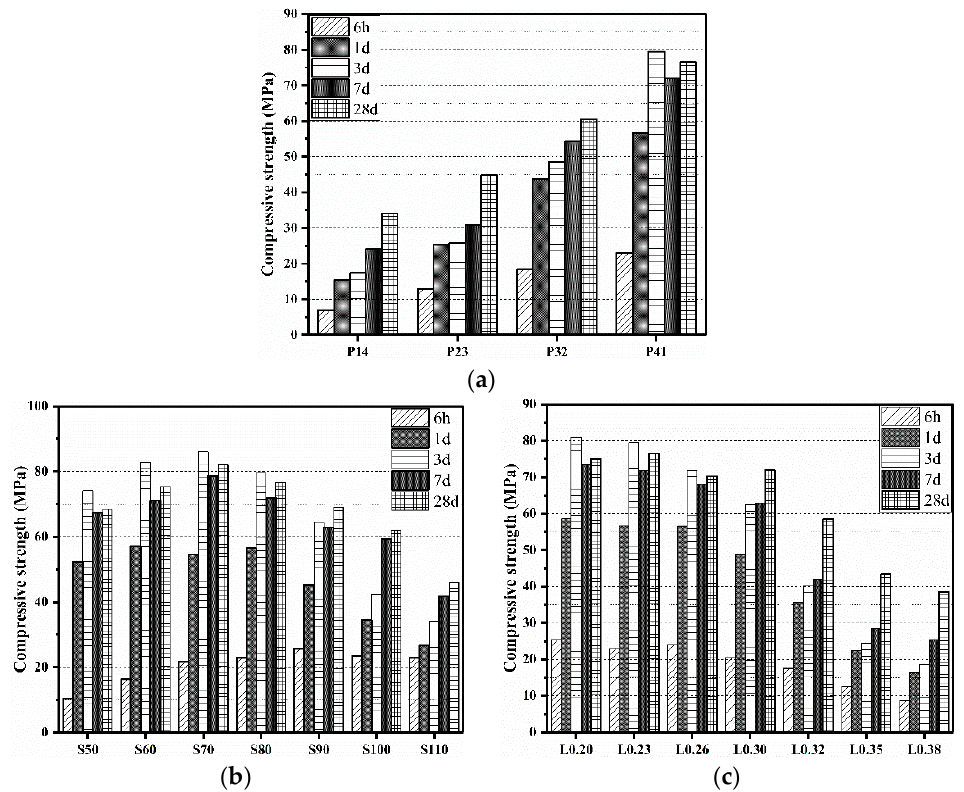
Figure 6. Effects of precursor composition, dosage of solid powdered sodium silicate and liquid–solid ratio on compressive strength: ( a ) Precursor composition, ( b ) Dosage of solid powdered sodium silicate, ( c ) Liquid–solid ratio.